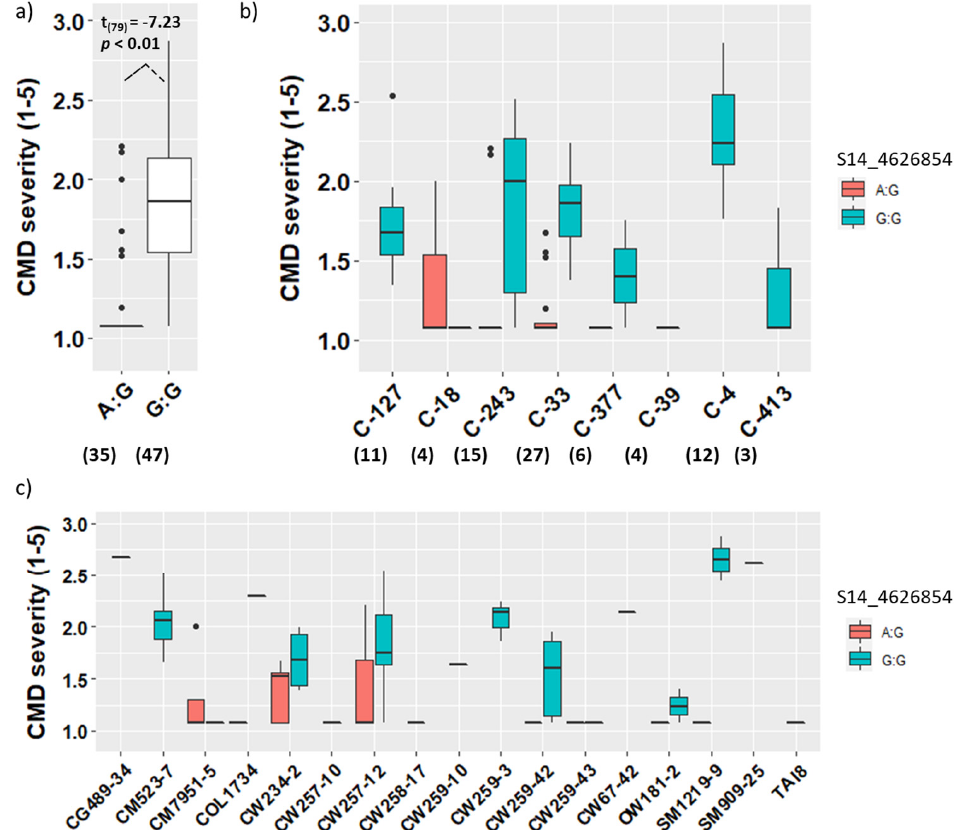
Figure 4. The CMD severity of the CIAT102 population grouped by the genotype of the CMD marker S14_4626854 or family structure. ( a ) The CMD severity of the different genotypes at 3 months after planting. Among the 82 clones in CIAT102, 35 clones had the resistant allele A. Significant differences among the genotypes with and without the resistant allele were observed (mean of the CMD severity scores 1.2 vs. 1.8). Five clones without the resistant allele A showed CMD resistance, and six clones with the resistant allele A showed CMD symptoms. ( b ) The CMD severity of the CIAT102 clones grouped by their genotype and the donor parents of CMD resistance. C-127, C-4, and C-413 did not produce progeny with the resistant allele A. ( c ) The CMD severity of the CIAT102 clones grouped by their genotype and other progenitors. The progeny of CW234-2 and CW257-12 showed segregation in CMD resistance when containing the resistant allele A.